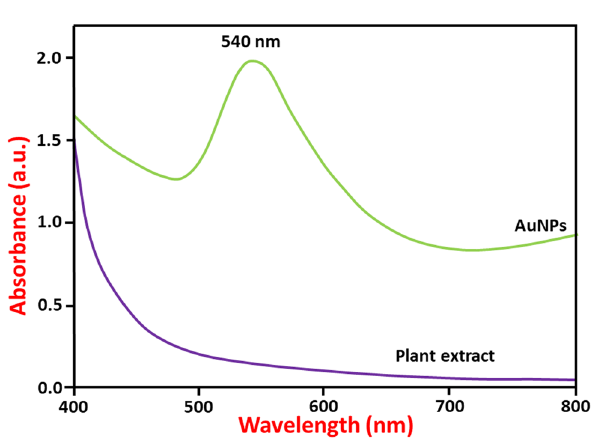
Figure 1: UV - Vis spectrum of